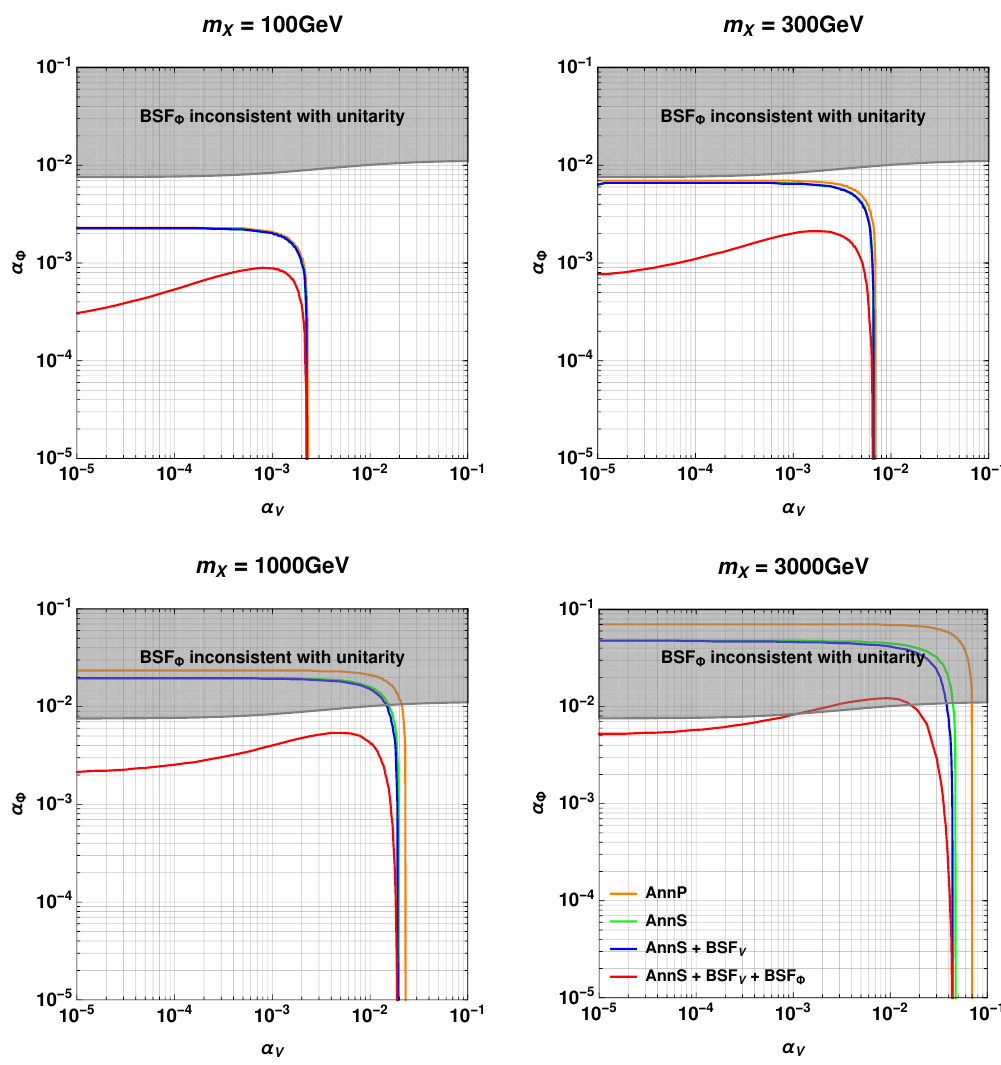
Figure 19 . The combination of the couplings (cid:11) for (cid:12)xed values of the DM mass, when considering di(cid:11)erent contributions to the DM